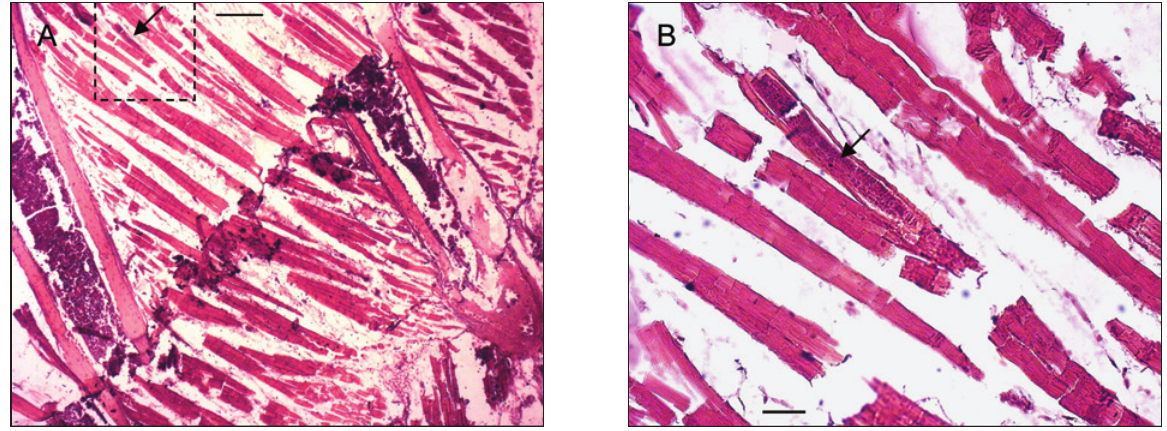
Fig. 2. – Trichosomoides nasalis in a thoracic muscle fibre. A, overview of ribs and musculature, parasite (arrow) within marked area. B, close-up of infected fibre. Arrow indicating parasite. Scale bars in μ m: A, 400; B, 50.